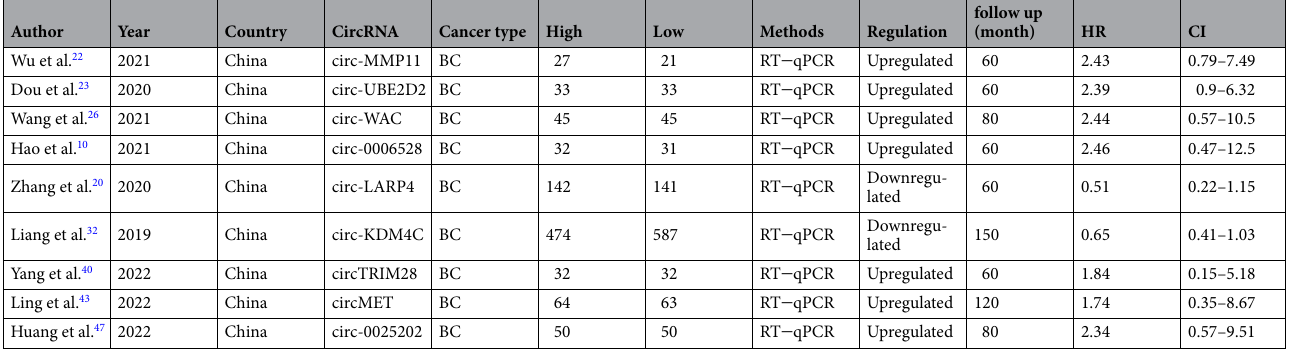
Table 2. Basic features of studies for prognostic analysis.